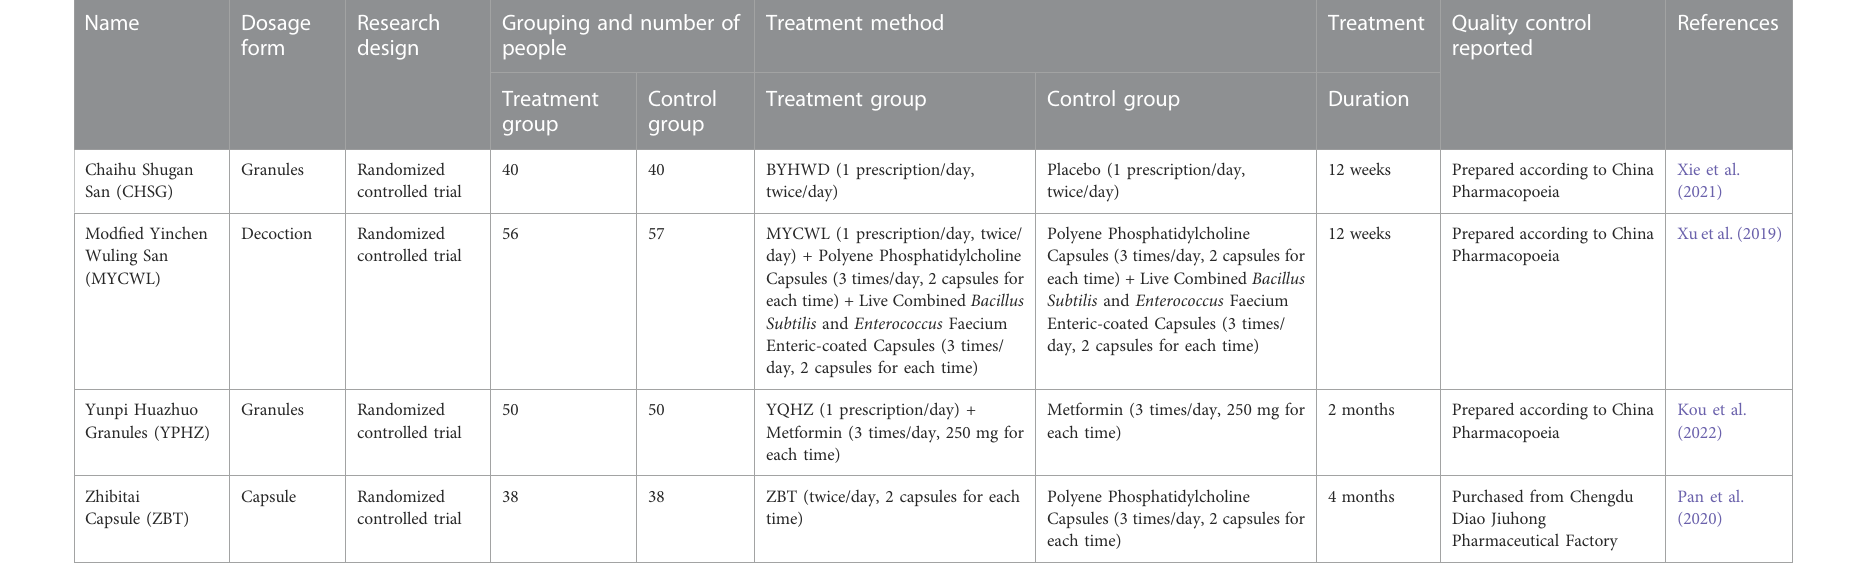
TABLE 2 Summary of TCM prescriptions used in clinical